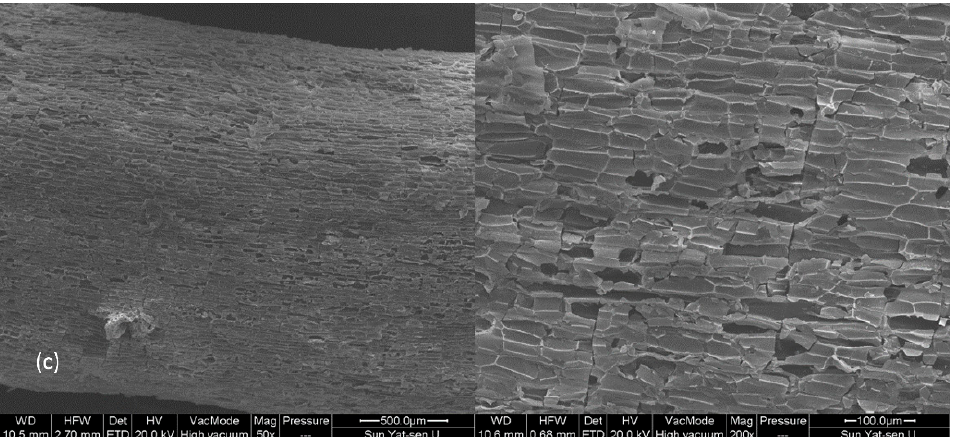
Figure 1. The SEM images of a Typha latifolia root segment from tailing soil treatment cleaned in steps by ( a ) deionized water; ( b ) PBS-S solution and ( c ) hydroxylammonium chloride solution. The images at the right show magnified regions of the images at the left. The round material above the root surface in ( a ) is external layer of iron plaque. The residues attached to the root surface in ( b ) are internal layer of iron plaque. The smooth, trellis-like structure in ( c ) is the root surface.